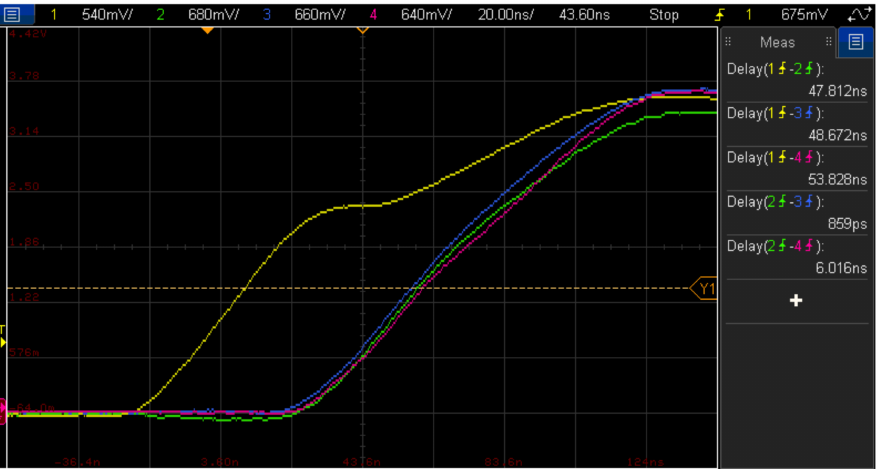
Figure 3. Global sync clock (yellow) and sampling clocks of Master Back-end units (green) and two Slave Back-end units (blue and red).